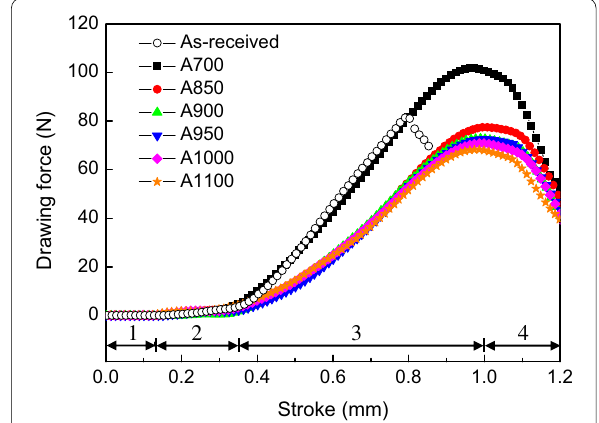
Figure 4 Variations of drawing force with stroke during